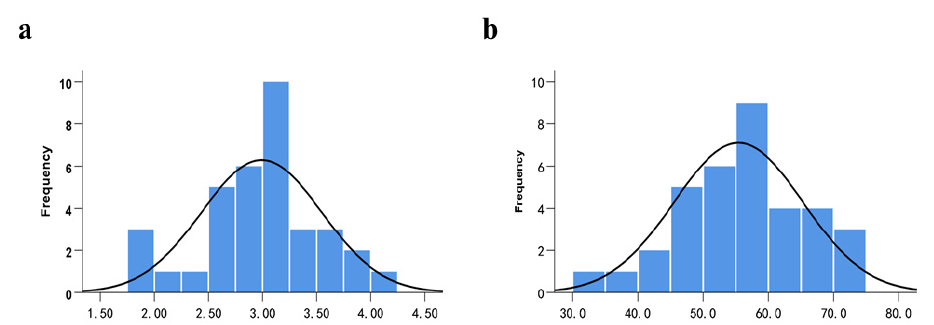
Figure 6. Frequency distribution of ( a ) biomass and ( b ) nitrogen accumulation in 35 tea germplasms.